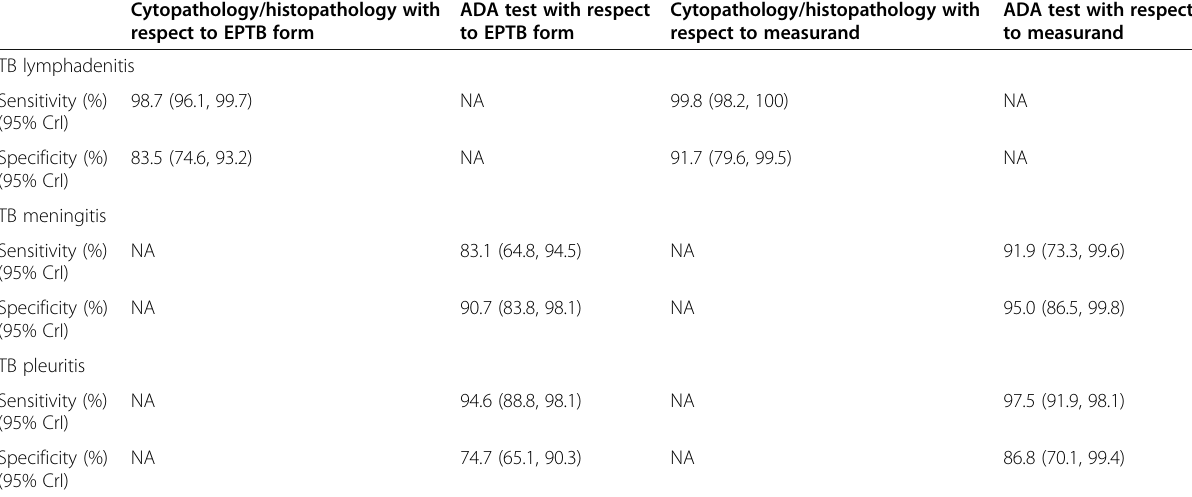
Table 2 Cytopathology/histopathology and ADA test performance with respect to each extrapulmonary TB form and measurands Cytopathology/histopathology with respect to EPTB